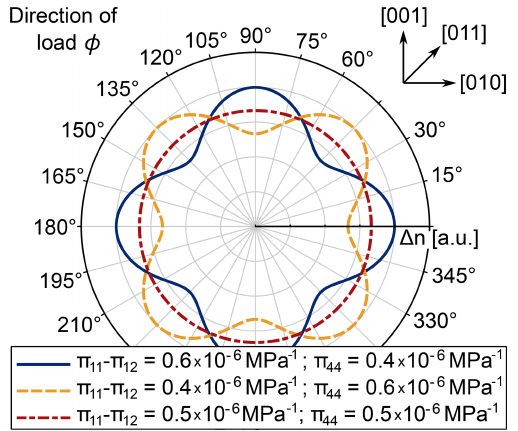
Figure 4. The stress-optical model derived for a {100}-silicon wafer with three arbitrarily chosen parameter combinations.